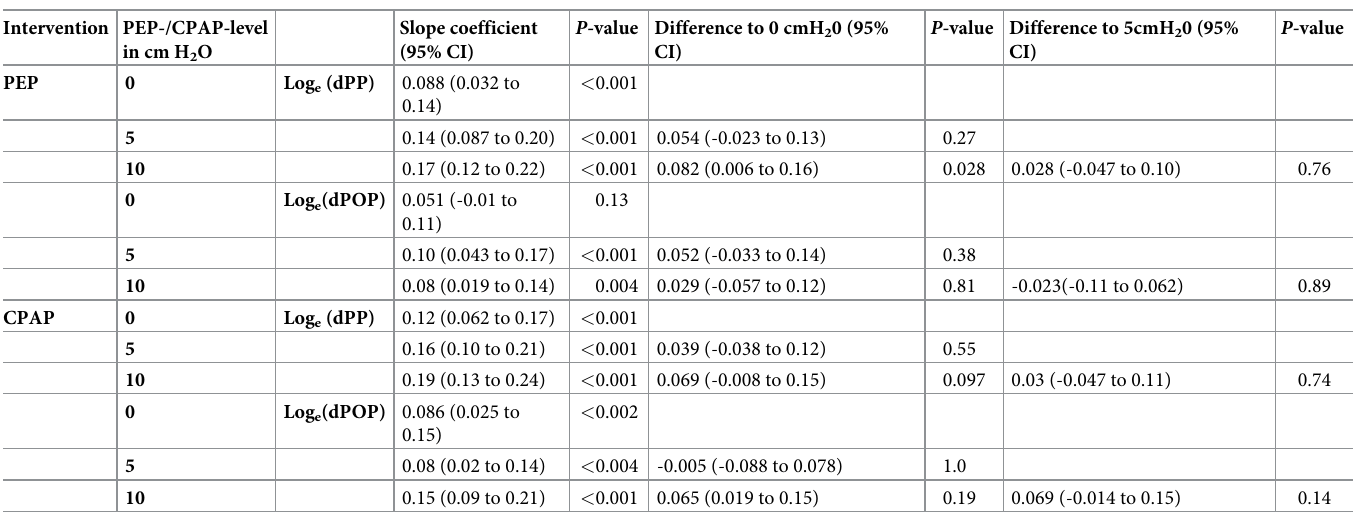
Table 1. Effects of LBNP-, PEP- and CPAP-level on dPP and dPOP. Intervention PEP-/CPAP-level in cm H 2 O